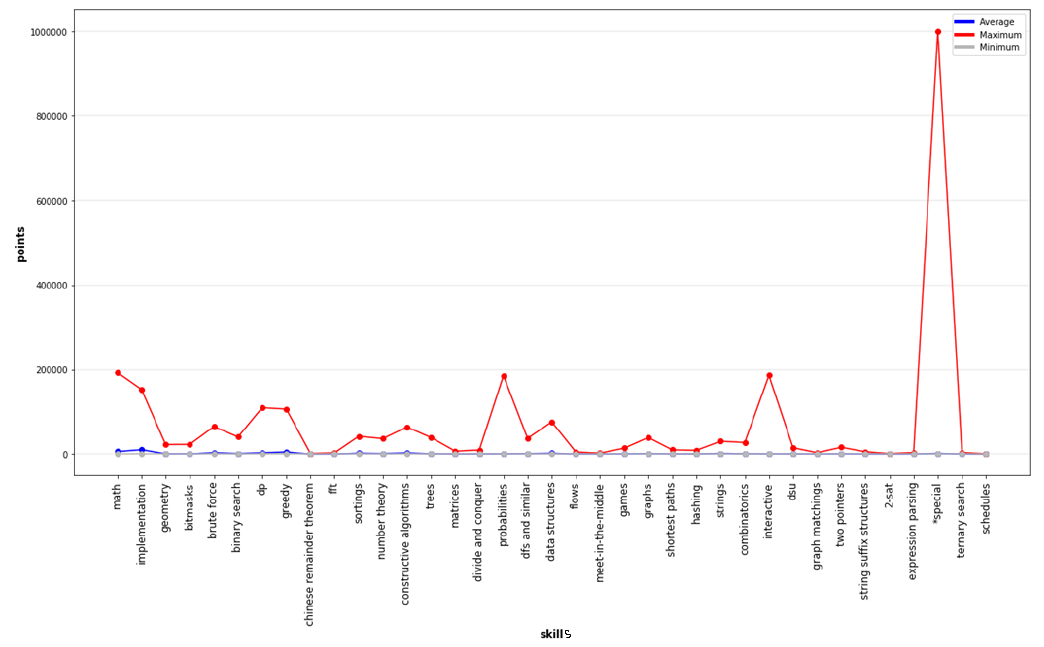
Figure 6. The minimum, maximum, and average scores that the users gained for their skills.